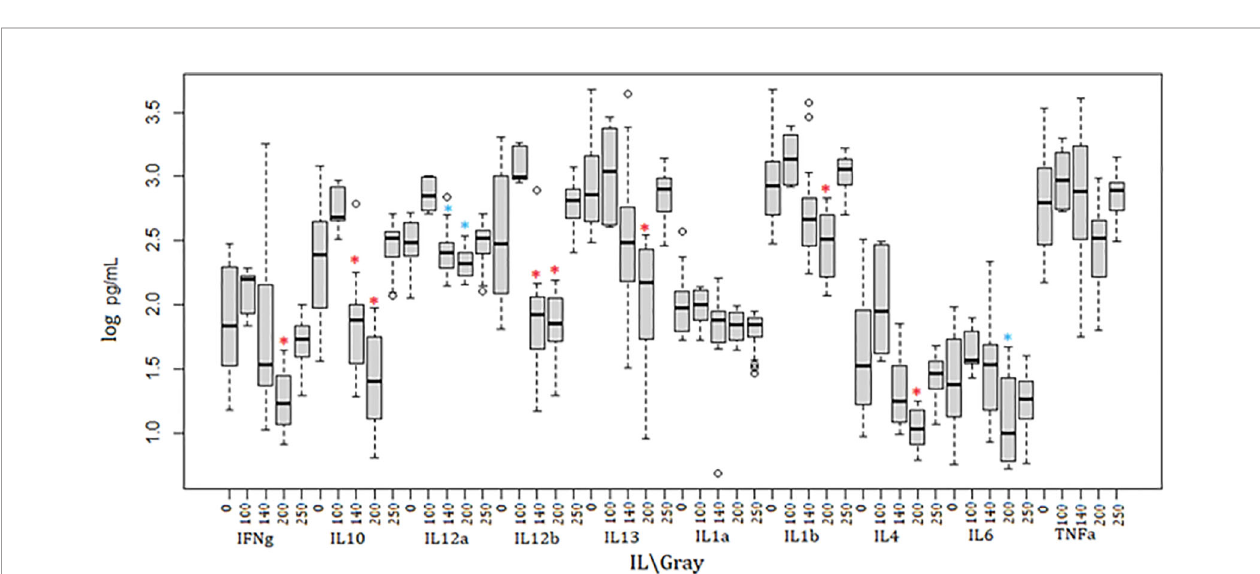
FIGURE 3 | Cytokine dynamics in mice immunized using irradiated parasites. Ten different cytokines were measured through the course of inoculation and challenge. Mice inoculated with 200Gy irradiated parasites had signi fi cantly lower levels of IFN g , IL10, IL12b, IL13, IL1b and IL4 when compared to 0Gy (*). IL12a and IL6 were signi fi cantly lower when comparing 200Gy to 100Gy irradiated parasite inoculation (*). Signi fi cantly lower IL10, IL12a and IL12b were also observed in mice inoculated with 140Gy irradiated parasites (*). Analyses were calculated using one-way ANOVA for each cytokine, *p <